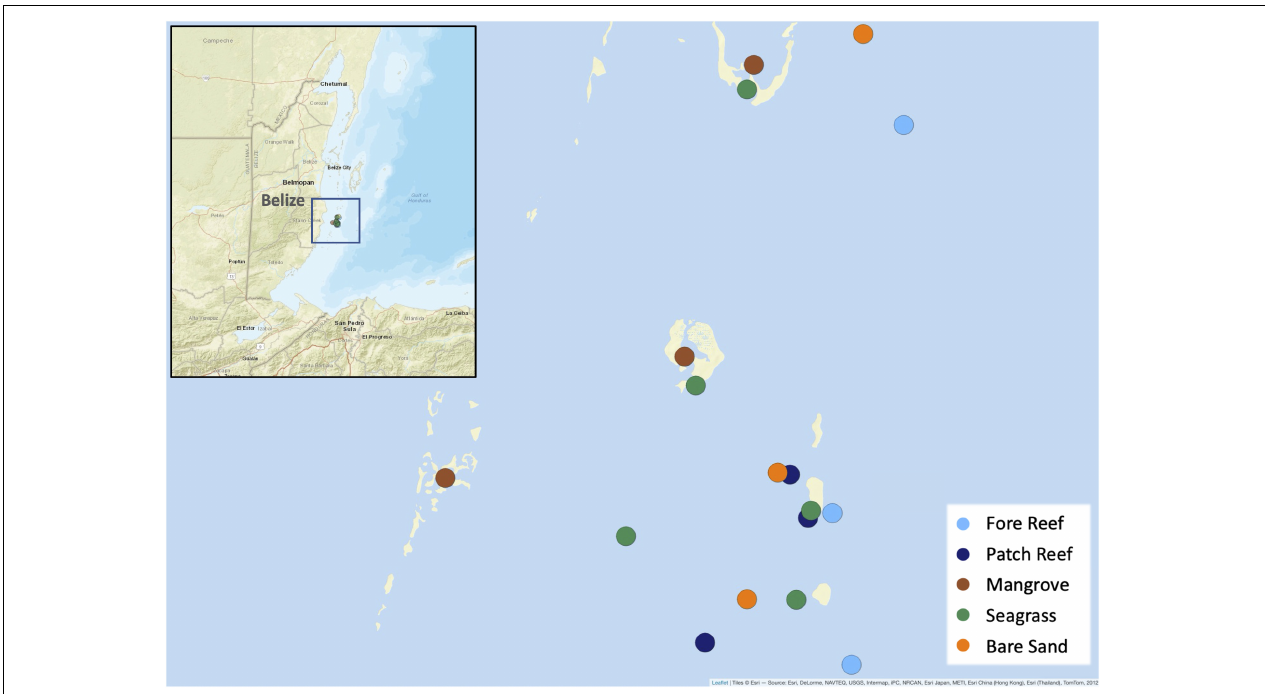
FIGURE 1 | Map of all Carrie Bow Cay sites off the coast of